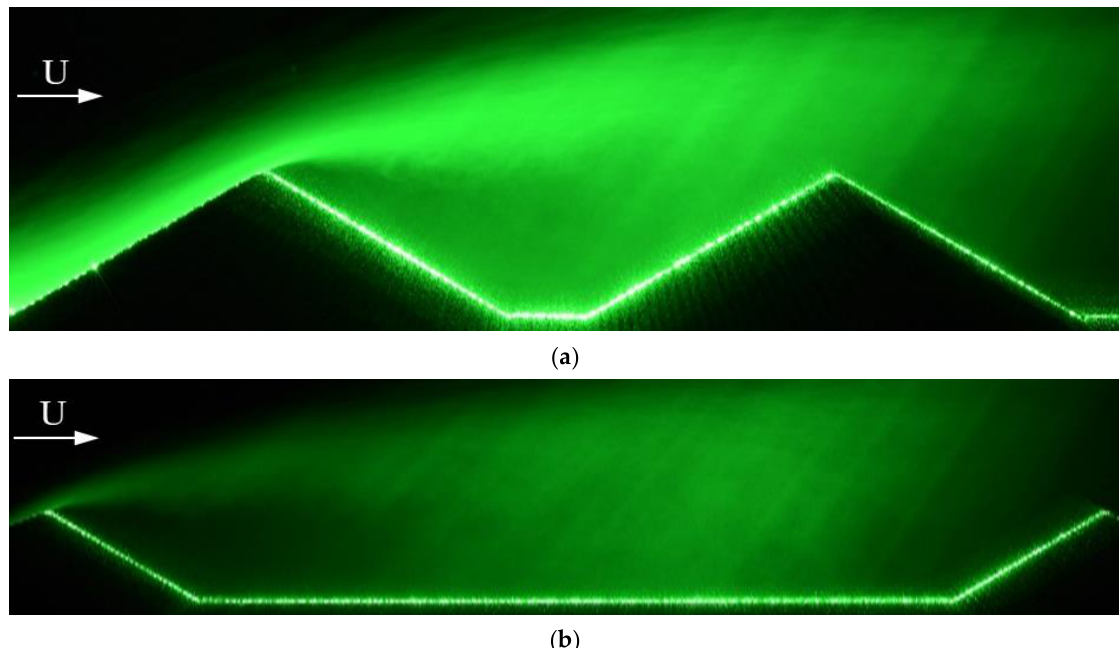
Figure 4. Lateral views of the approximate streaklines observed in the vertical planes with a laser light-sheet and smoke above the smallest width valley, A = 4H ( a ), and the largest width valley, A = 12H ( b ). U represents the longitudinal flow direction.